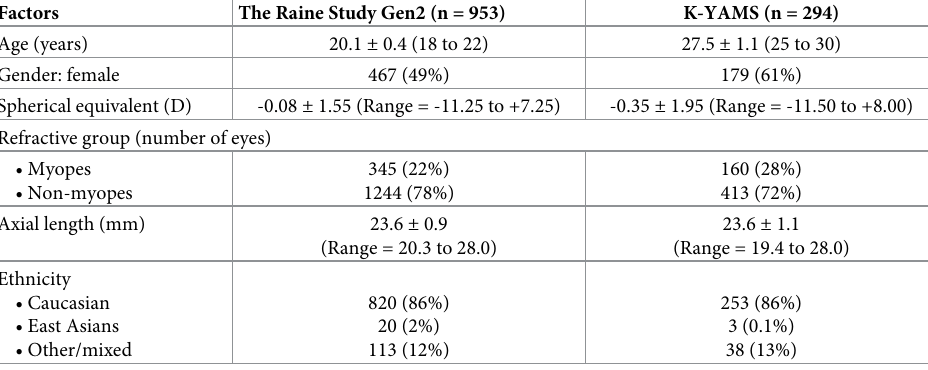
Table 1. Demographic information of the study participants